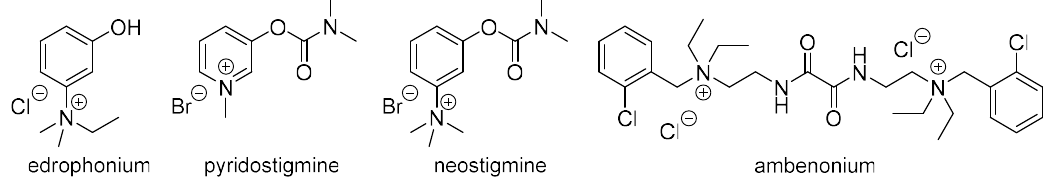
Figure 1. Chemical structures of peripherally-acting AChEIs used for diagnosis and symptomatic treatment of myasthenia gravis.